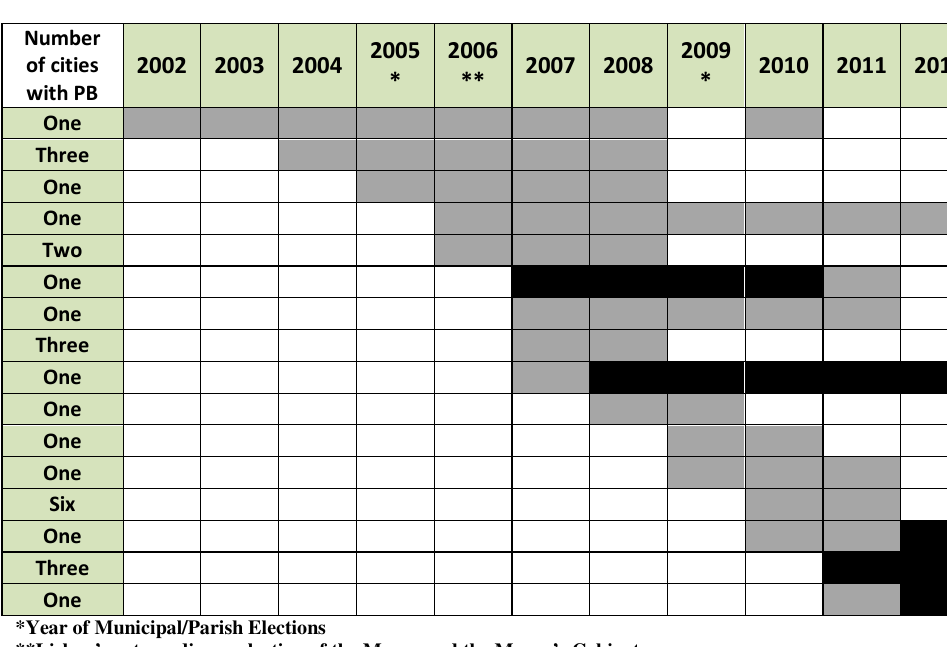
Continuum of Portuguese PB at municipal level (2001-2012) 15